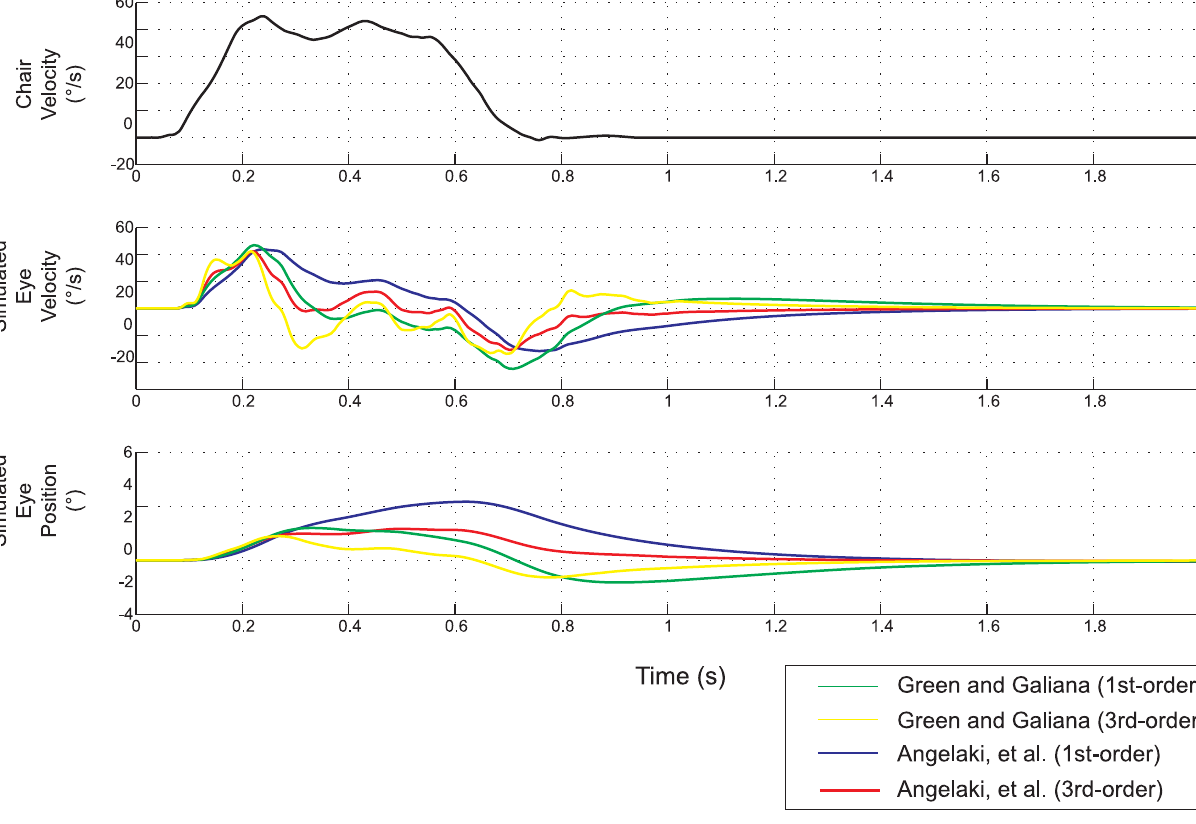
Figure 8. Effect of choice of eye plant model on the simulated eye movement. The top panel shows the head velocity profile of the input. The bottom two panels compare simulated eye velocity and position using the simple first order plant (time constant 0.25 ms) and the third-order plant.